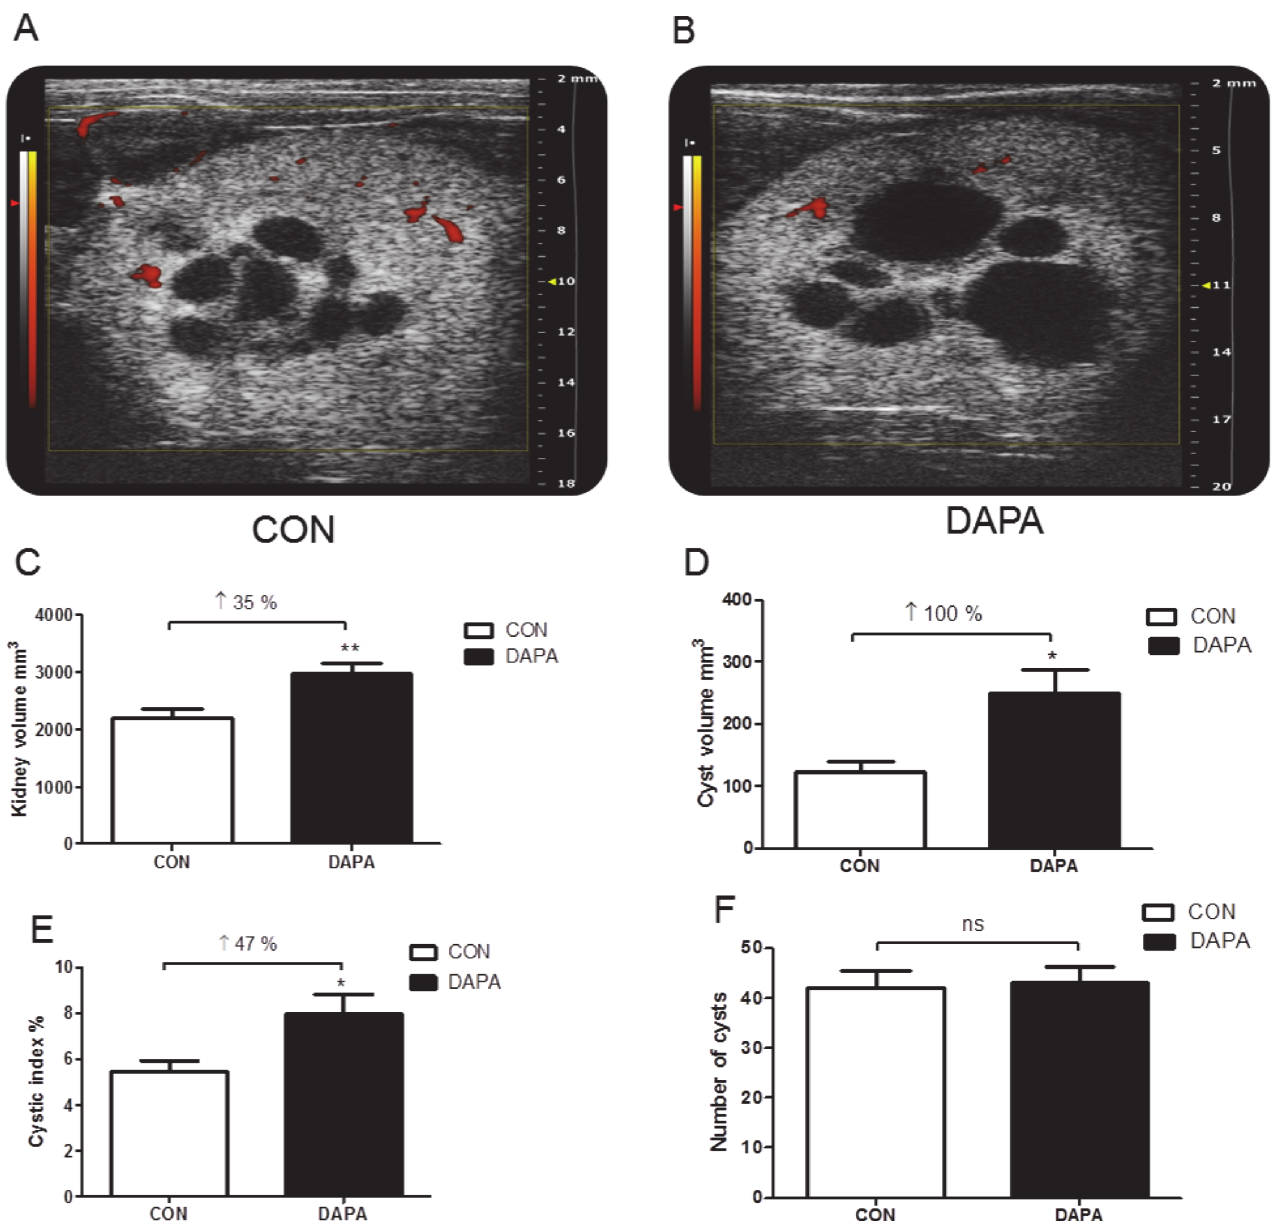
Fig 3. Effect of DAPA on kidney volume and cystic index. Typical 2D transverse power Doppler ultrasound images of a kidney in CON- and DAPA- treated PCK rats. The red areas represent a power Doppler signal consistent with blood flow within the renal vasculature. The maximum scan distance between cranial and caudal poles of the kidney was 28 mm. The slice thickness between scanning planes was 0.072 mm with a maximum of 500 slices (A, B). Change in kidney volume (C), cyst volume (D), cystic index (E) and number of cysts (F) in PCK rats. N = 6 rats or 12 kidneys per group. Columns represent means ± SE. * P < 0.05, ** P < 0.01, ns = non-significant.